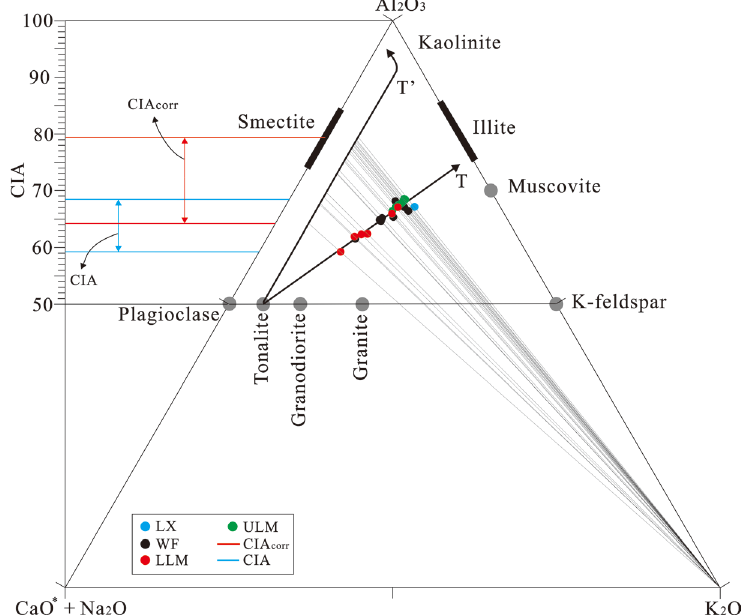
Figure 6. Al 2 O 3 – CaO* + Na 2 O –K 2 O ternary diagrams exhibiting weathering degree (all in mole percentages). The CIA corr values of most samples range from 70 to 80, indicating a moderate degree of chemical weathering and a warm and humid palaeoclimate. Note: T and T’ are the actual and predicted weathering trends, respectively.